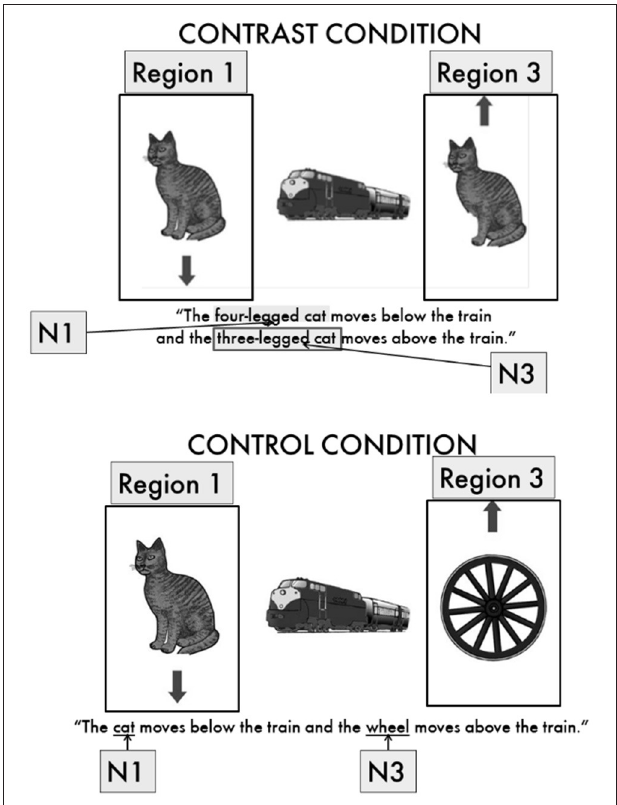
FIGURE 1 | Contrast and control conditions in Swets et al. (2014). Figures 1 and 2 are reprinted from Swets (2015). With permission from Peter Lang International Academic Publishers, Frankfurt am Main, Berlin, Bern, Bruxelles, New York, Oxford, Wien, copyright